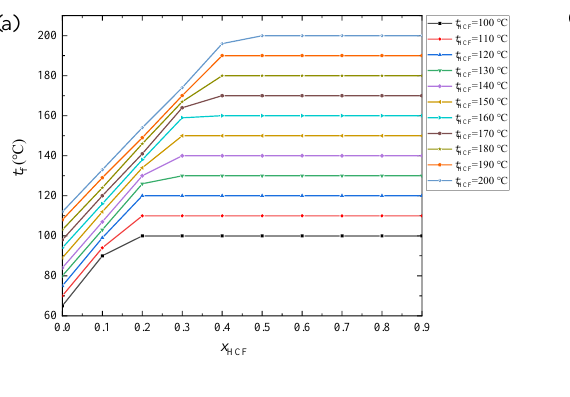
Figure 13. Variation trend of W net of three energy conversion systems: ( a ) SF system, ( b ) ORC system